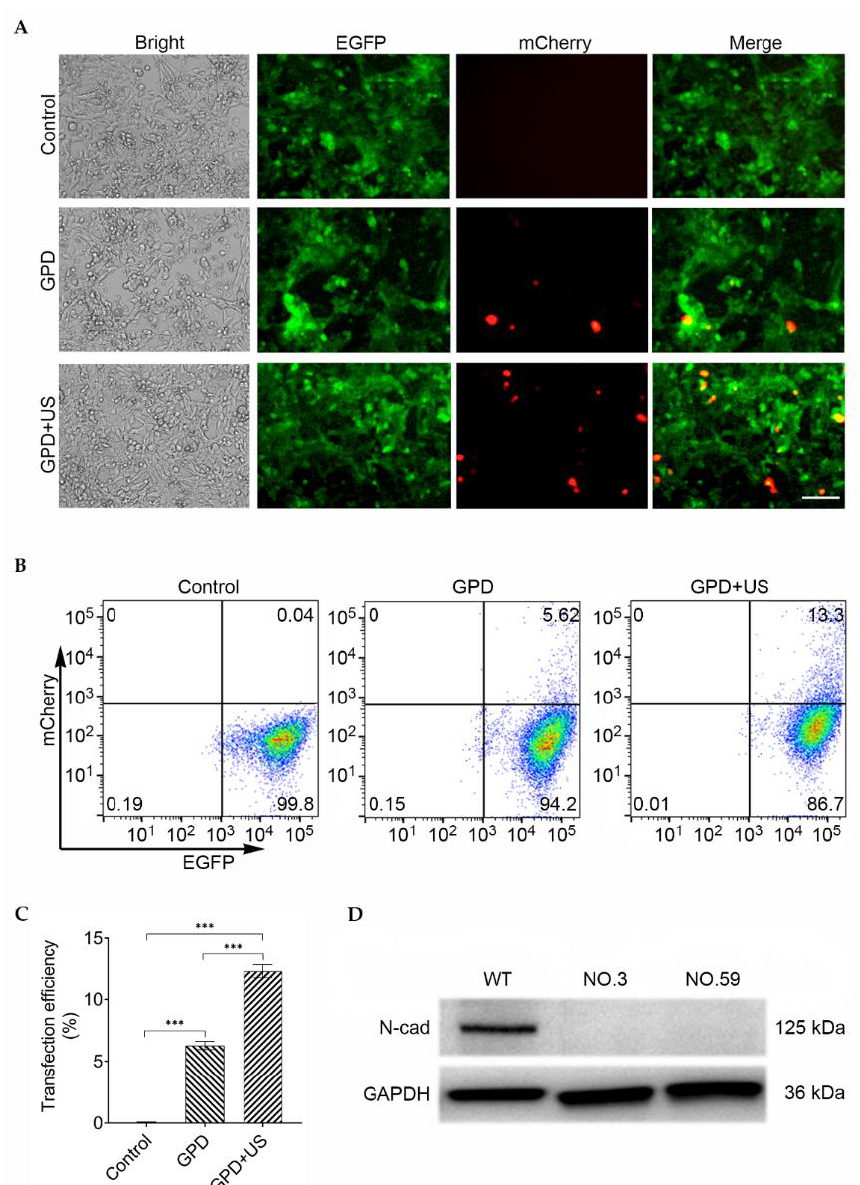
Figure 3. ( A ) Fluorescence images of Cas9- and EGFP-stably expressed 4T1 cells transfected with only pU6-sgRNA (Cdh2)-mCherry (control), GPD, or GPD + US (GPD: the abbreviation of GVs–PEI–DNA). Scale bar = 100 µ m; ( B ) determination of the transfection efficiency by flow cytometry through the counting of the red-emitting cells in EGFP-expressed cells; ( C ) quantitative analysis of the mCherry-expressed cells from ( B ) ( n = 3) *** p < 0.001. ( D ) Western blotting assay of the expression of N-cadherin in the wild-type (WT) and two Cdh2-KO cell lines. GAPDH was used as an internal